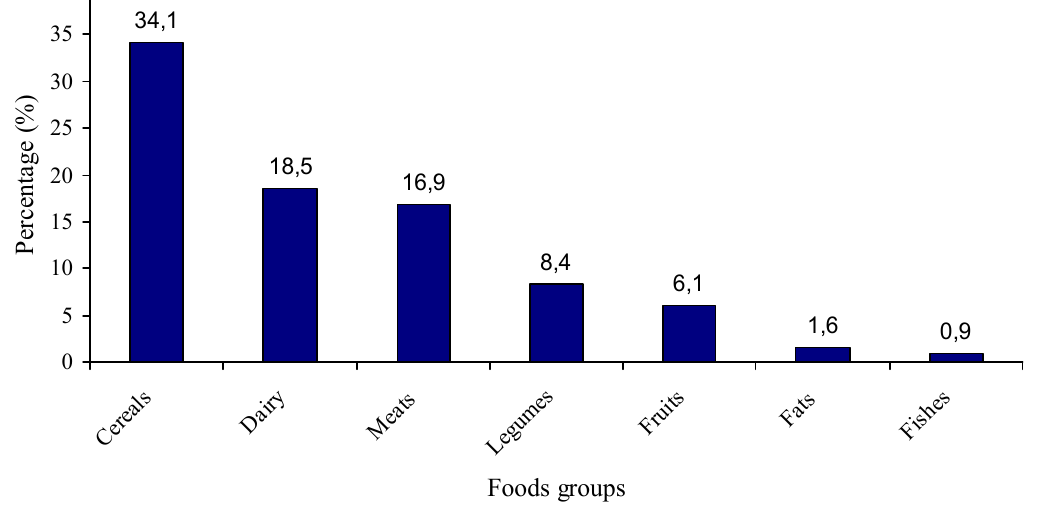
Figure 1. Percentage contribution of the different food groups to daily calorie intake.